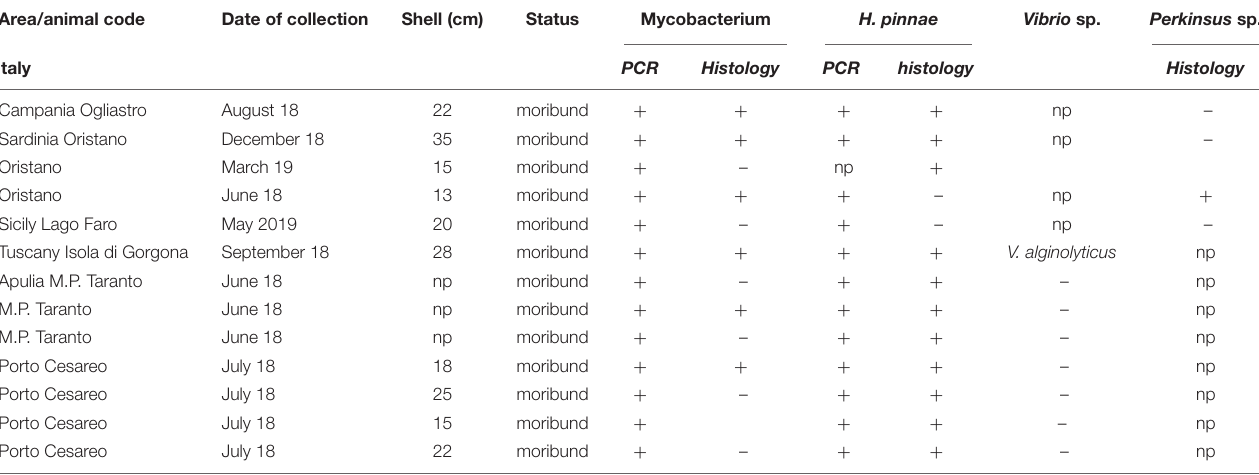
TABLE 2 | Sampling data of the 13 Pinna nobilis specimens from Italy analyzed in the study and results of the detection of Mycobacterium , H. pinnae and other pathogens by histology and molecular diagnostic. Area/animal